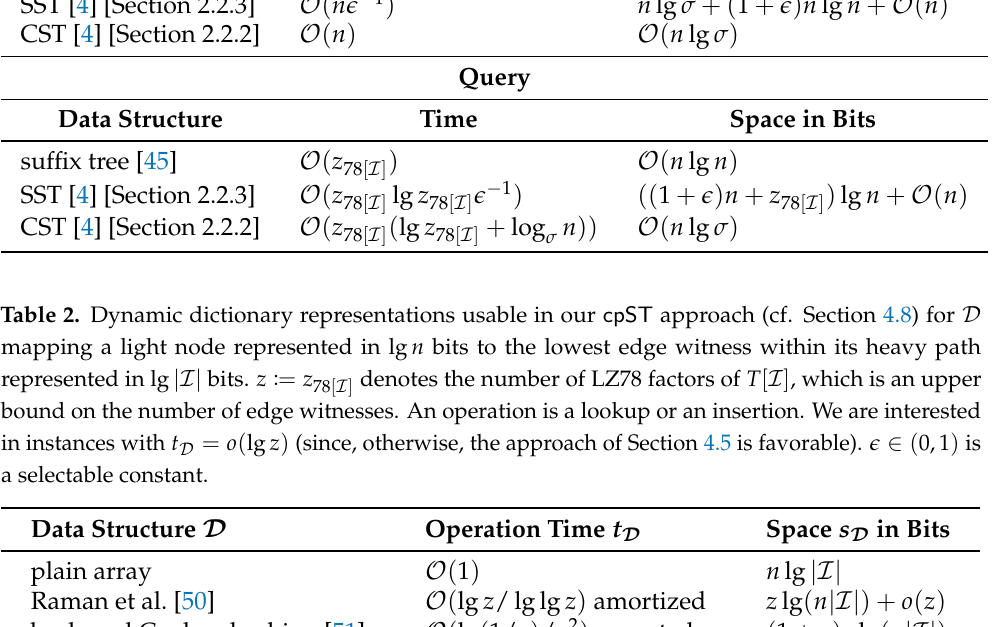
Table 1. Complexities for answering an LZ78 substring compression query with different suffix tree [ 1 .. n ] . A query additionally needs an array of representations. The query is on an interval I ⊂ z 78 [ ] lg n = O ( n lg σ ) bits of space as described in Section 4.7. If there are characters of the alphabet I appearing nowhere in the text, we additionally need to keep the text available during a query, which adds n lg σ bits to the query space complexity of the SST solution.